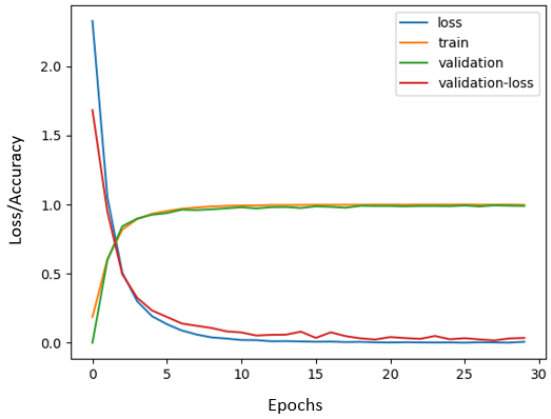
Figure 8. Accuracy and loss graph during the training